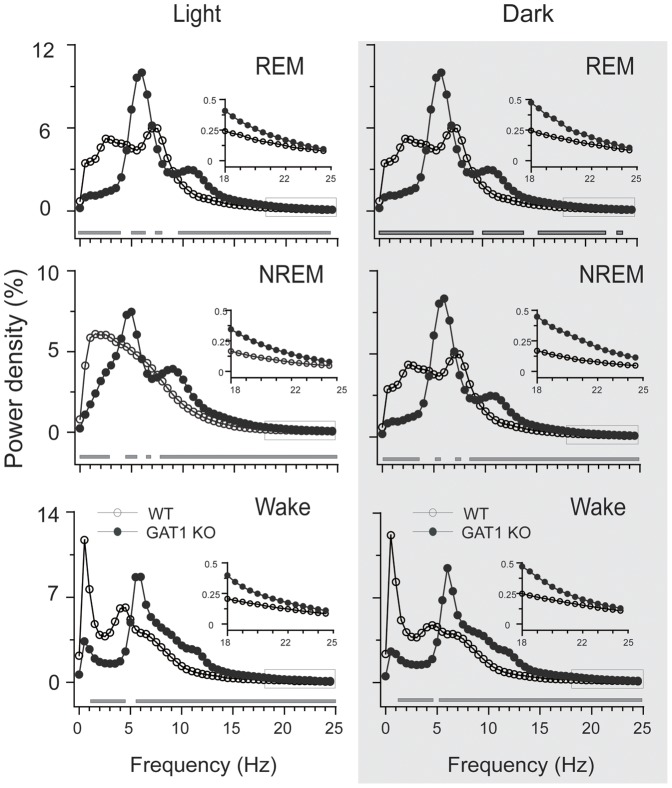
GAT1 KO mice displayed dominant EEG theta-activity.EEG power density curves for each stage during light (left panel) and dark (right panel) periods. The horizontal bars indicate where there is a statistical difference (P<0.01) between the WT (n = 7) and KO mice (n = 8), assessed by unpaired t- test.